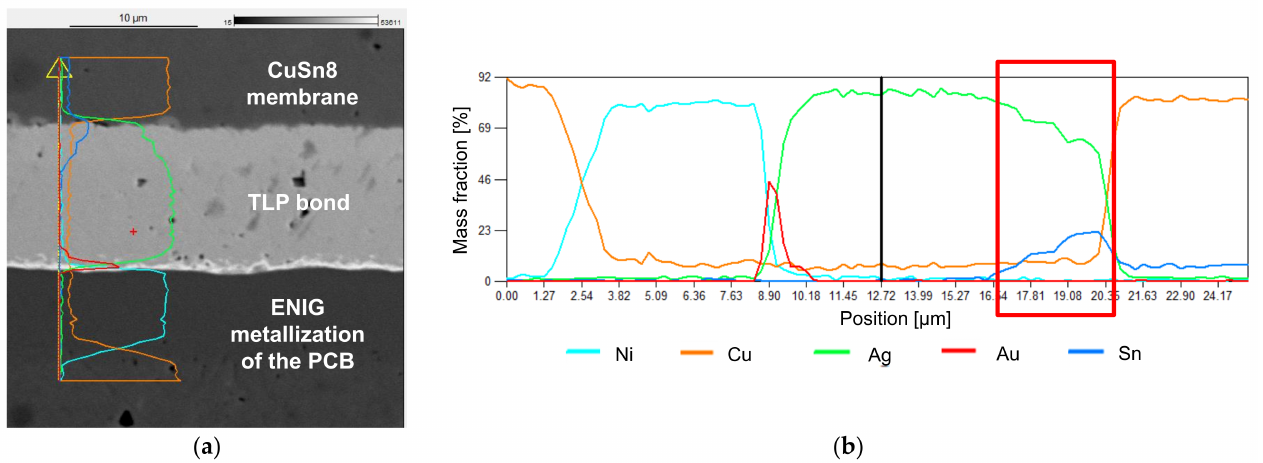
Figure 16. SEM-EDX image with elemental analysis of the TLP bond: ( a ) image with indication of the position of the EDX line scan; ( b ) EDX elemental analysis of the bond (line scan).